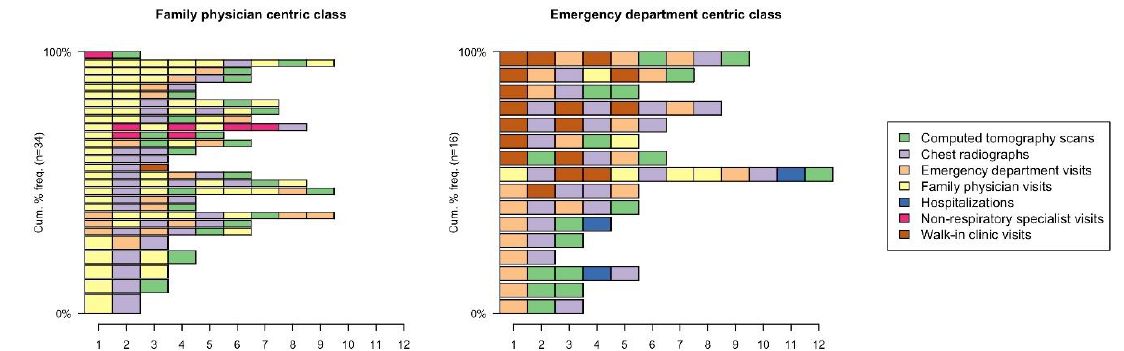
Figure 6. Sequence of utilization activities for each patient showing the order of specific events within the pathway stratified by group.